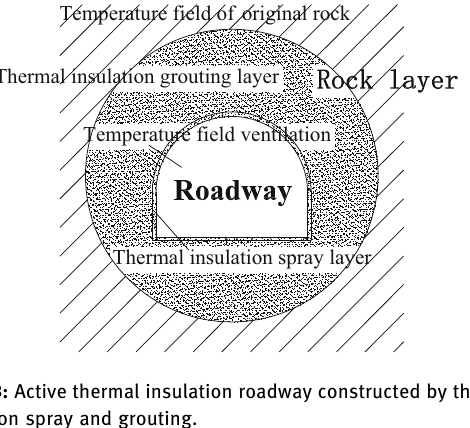
Figure 3: Active thermal insulation roadway constructed by thermal insulation spray and